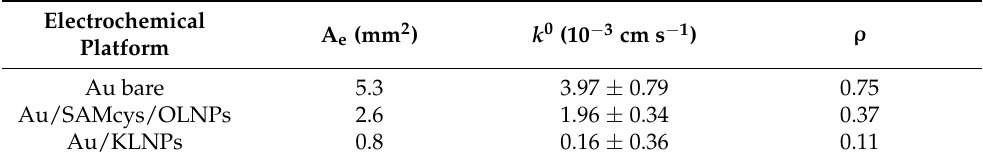
Table 1. Comparison of electrochemical parameters before and after the modification of Au